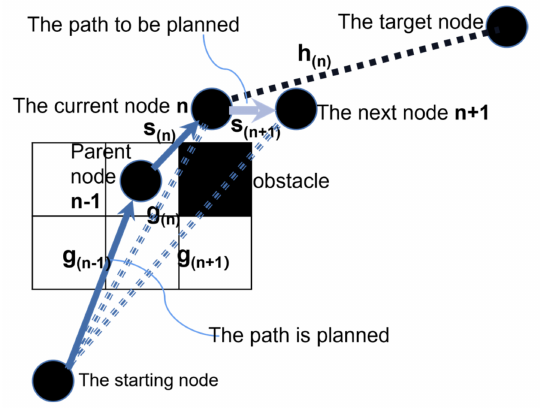
Figure 1. Diagram of the relationship between